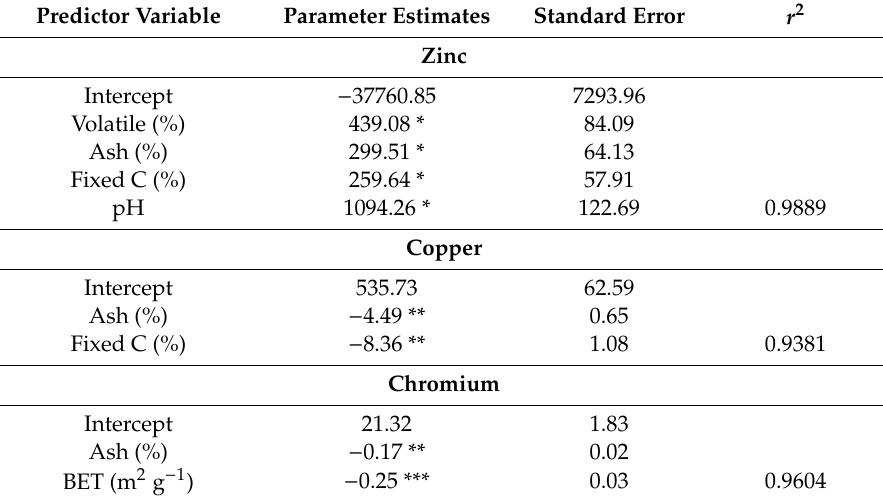
Table 5. Step-wise regression analysis for parameters a ff ecting Zn, Cu and Cr sorption maximum: presentation of the best-fit